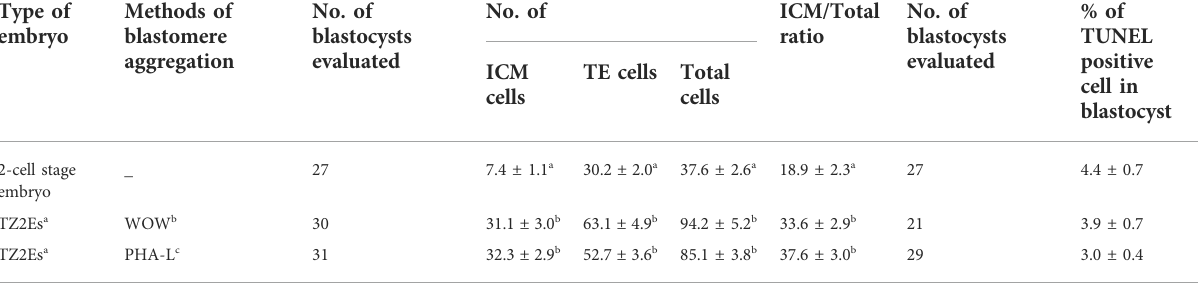
TABLE 5 Effects of Phytohemagglutinin (PHA-L) on the number of inner cell mass (ICM) the trophectoderm (TE) and apoptosis of blastocyst in pigs. Type of embryo